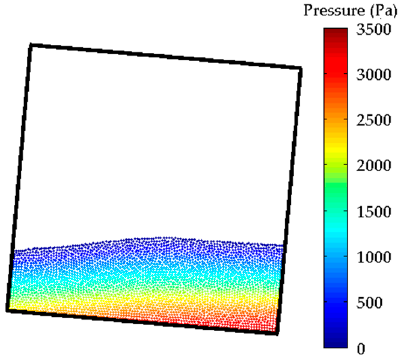
Figure 20. Flow pattern and pressure distribution in the SPH simulation